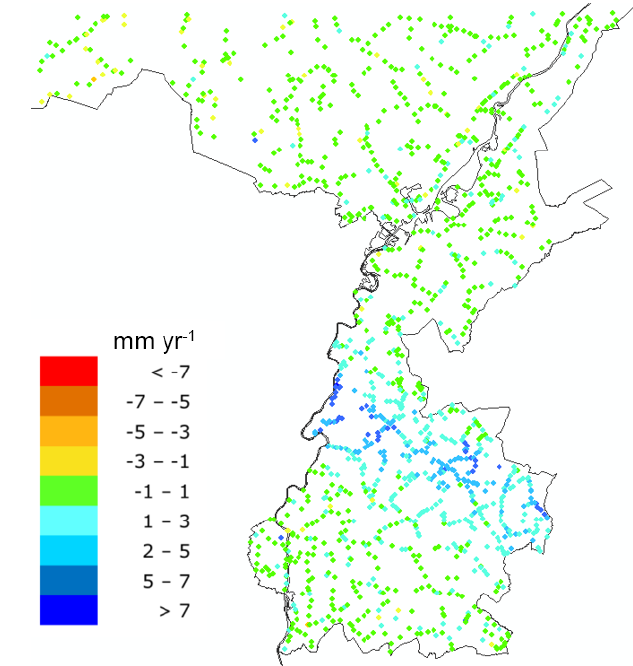
Figure 4. Result of the estimation of deformation at the locations of the NAP benchmarks.